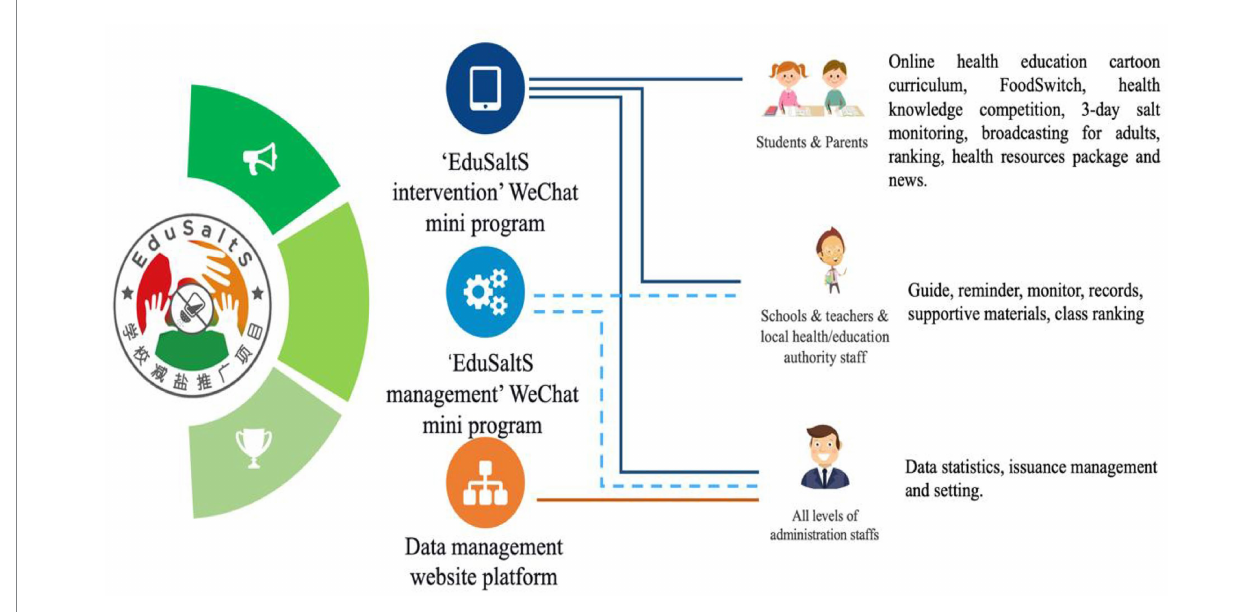
FIGURE 2 Three electronic components of the ‘EduSaltS’